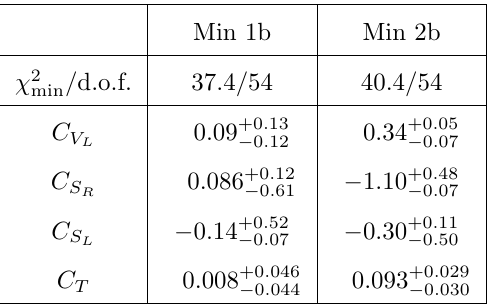
D (cid:3) and polarization, using ( B c (cid:3) [12] and the F L R D R D B !